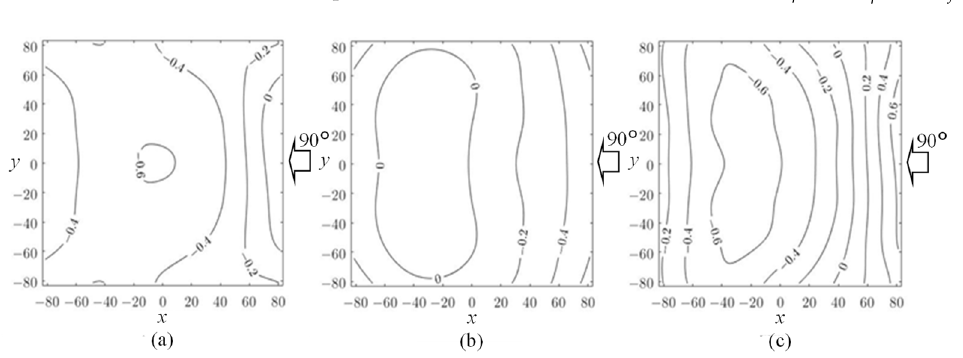
◦ : ( a ) C pt , ( b ) C pb , ( c ) C f